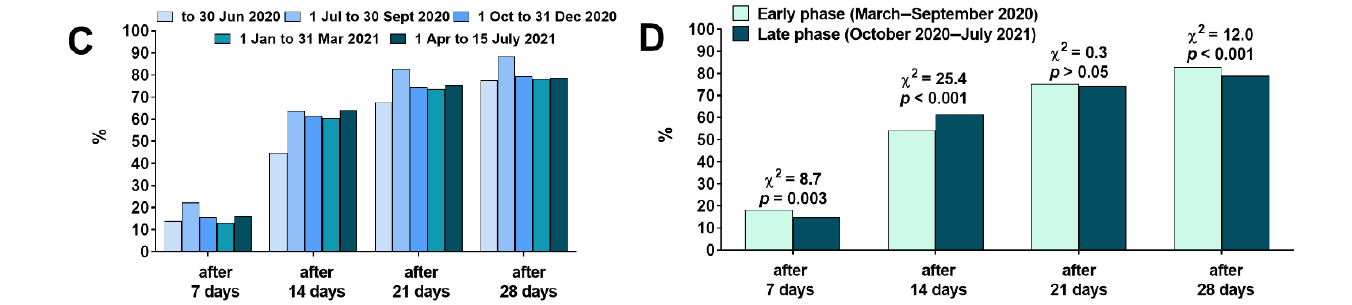
Figure 3. ( A ) The frequency of patients with baseline SpO 2 < 91%, requiring oxygen therapy and mechanical ventilation, and with fatal outcome in different periods of the pandemic ( n = 5199) and ( B ) comparison of these events between the early and late phase of the pandemic. ( C ) Percentage of patients with improvement in the clinical course of COVID-19 defined as a reduction in the score of at least 2 points on the ordinal 8-score scale (see Material & Methods for a detailed explanation of each score) in different periods of the pandemic and ( D ) comparison of these percentages between the early and late phase of the pandemic.